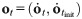
Analysis of policy parameters, with CMA-ES applied to ot=(o˙t,o˙tinit).
ρ¯ denotes the correlation coefficient, m and b the slope and intercept of the linear fit.